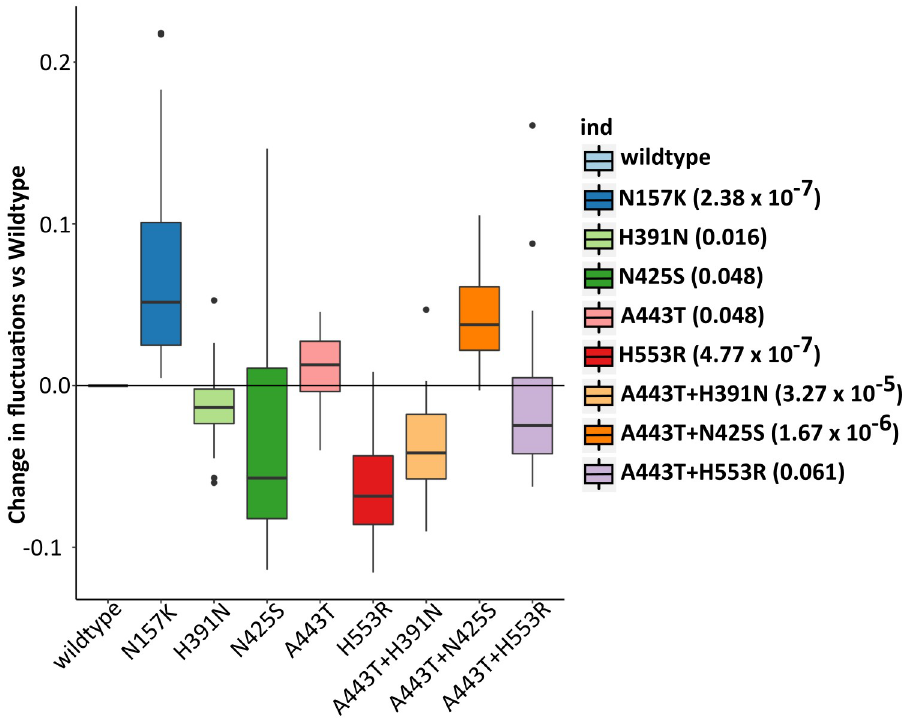
Fig 5. Assessment of PCSK9-LDLR binding stability for the mutant sequences from the five POINT-identified loci using molecular dynamic simulations. There are 8 mutant sequences observed in ACCORD samples, four of which have significant conformational fluctuation changes comparing to wildtype sequence: N157K, H553R, A443T+H391N, and A443T+N425S. P-values from Wilcoxon rank sum test of difference in RMSF are shown in parentheses.